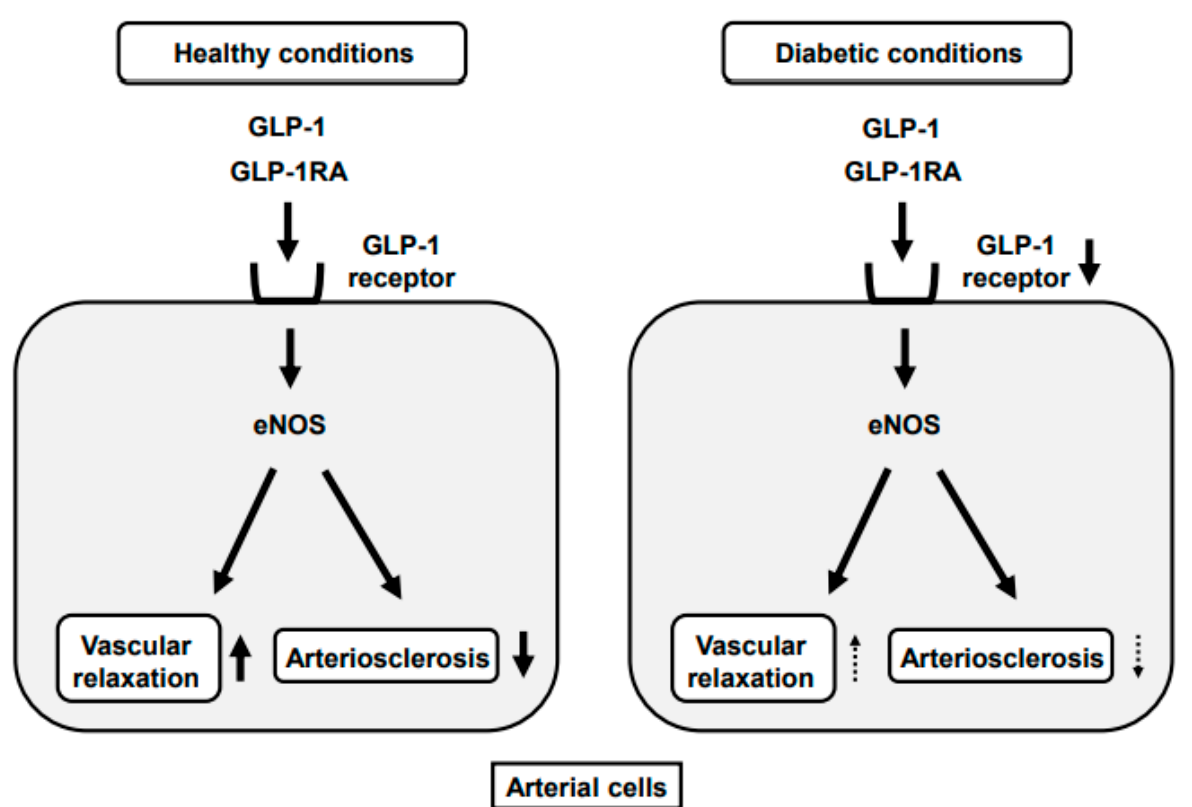
Figure 2. Reduction of GLP-1RA effects on arterial cells under diabetic conditions. GLP-1 binds to its receptor in arterial cells, which leads to the enhancement of vascular relaxation and the prevention of arteriosclerosis. After chronic exposure to hyperglycemia, however, GLP-1 receptor expression in arterial cells is reduced, which weakens the protective effects GLP-1 and GLP-1RA against arteriosclerosis.